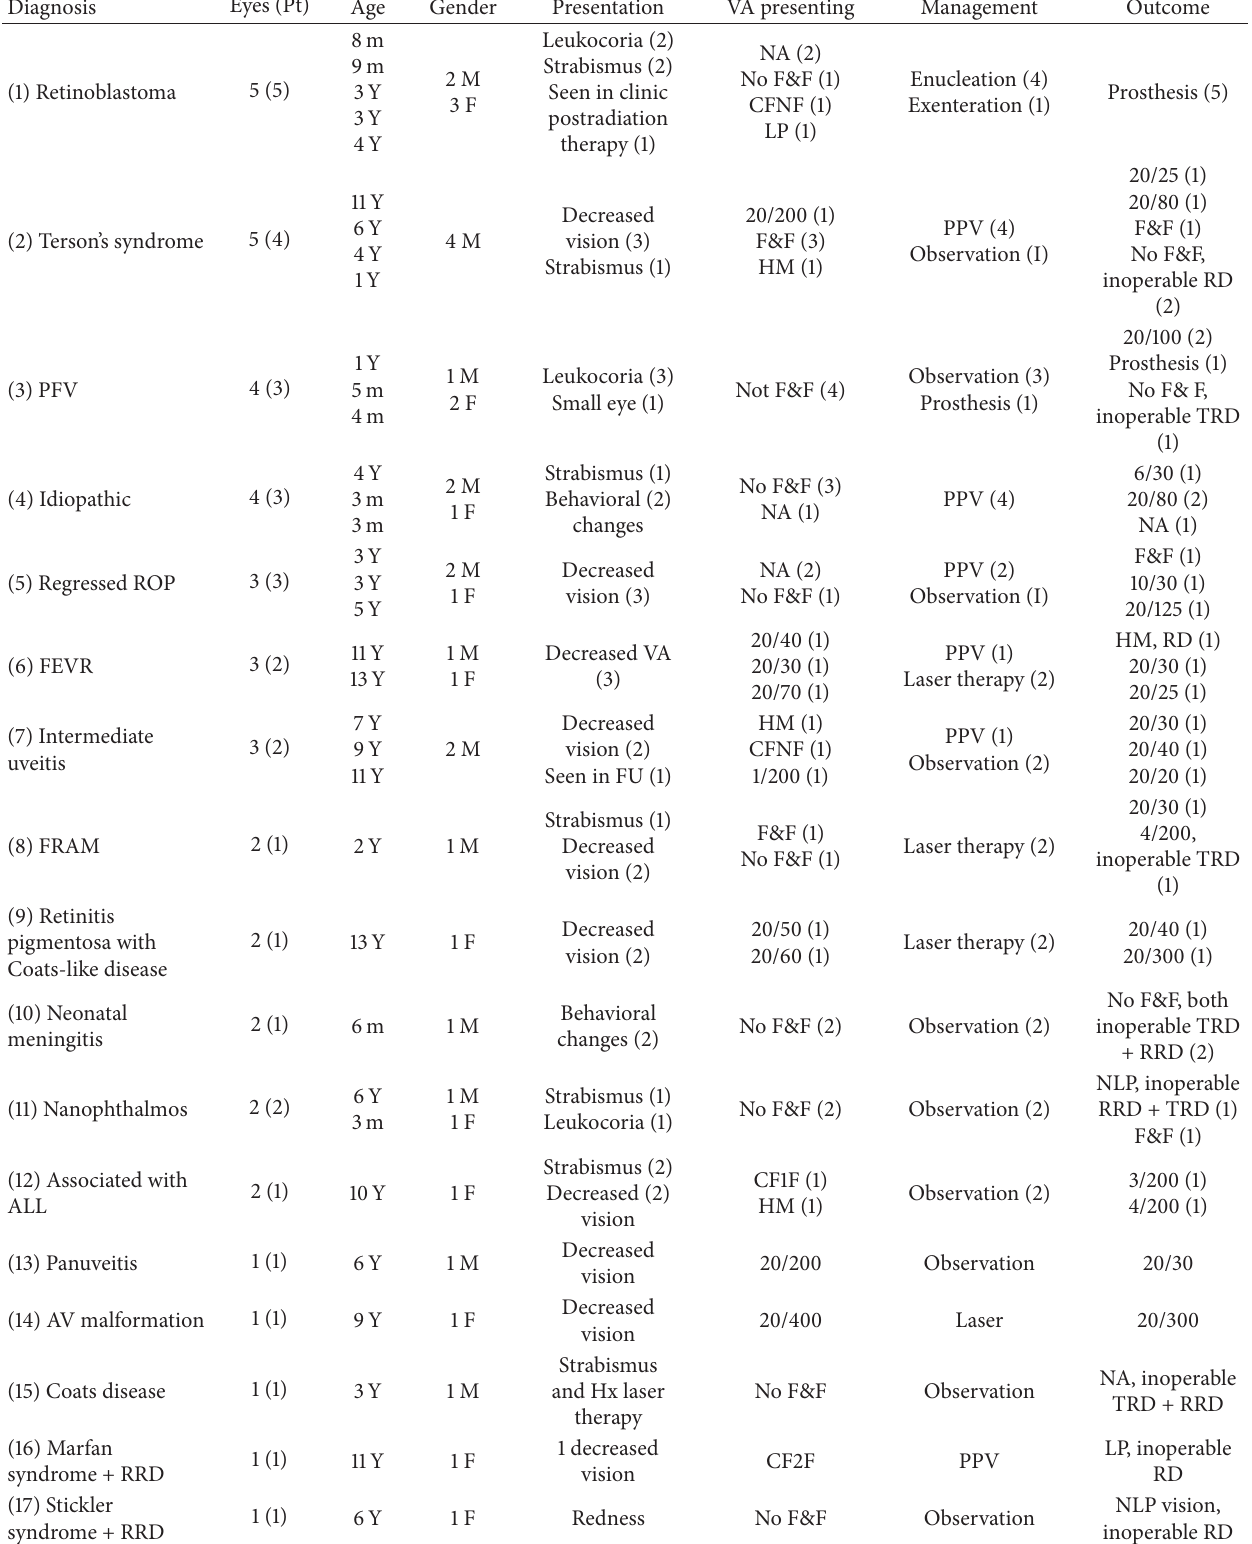
Table 4: Summary of the causes of nontraumatic vitreous